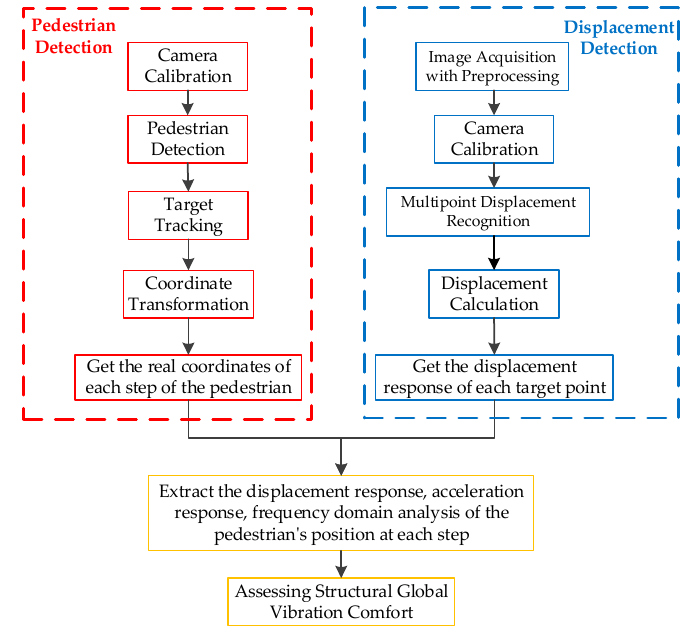
Figure 1. Flow chart.